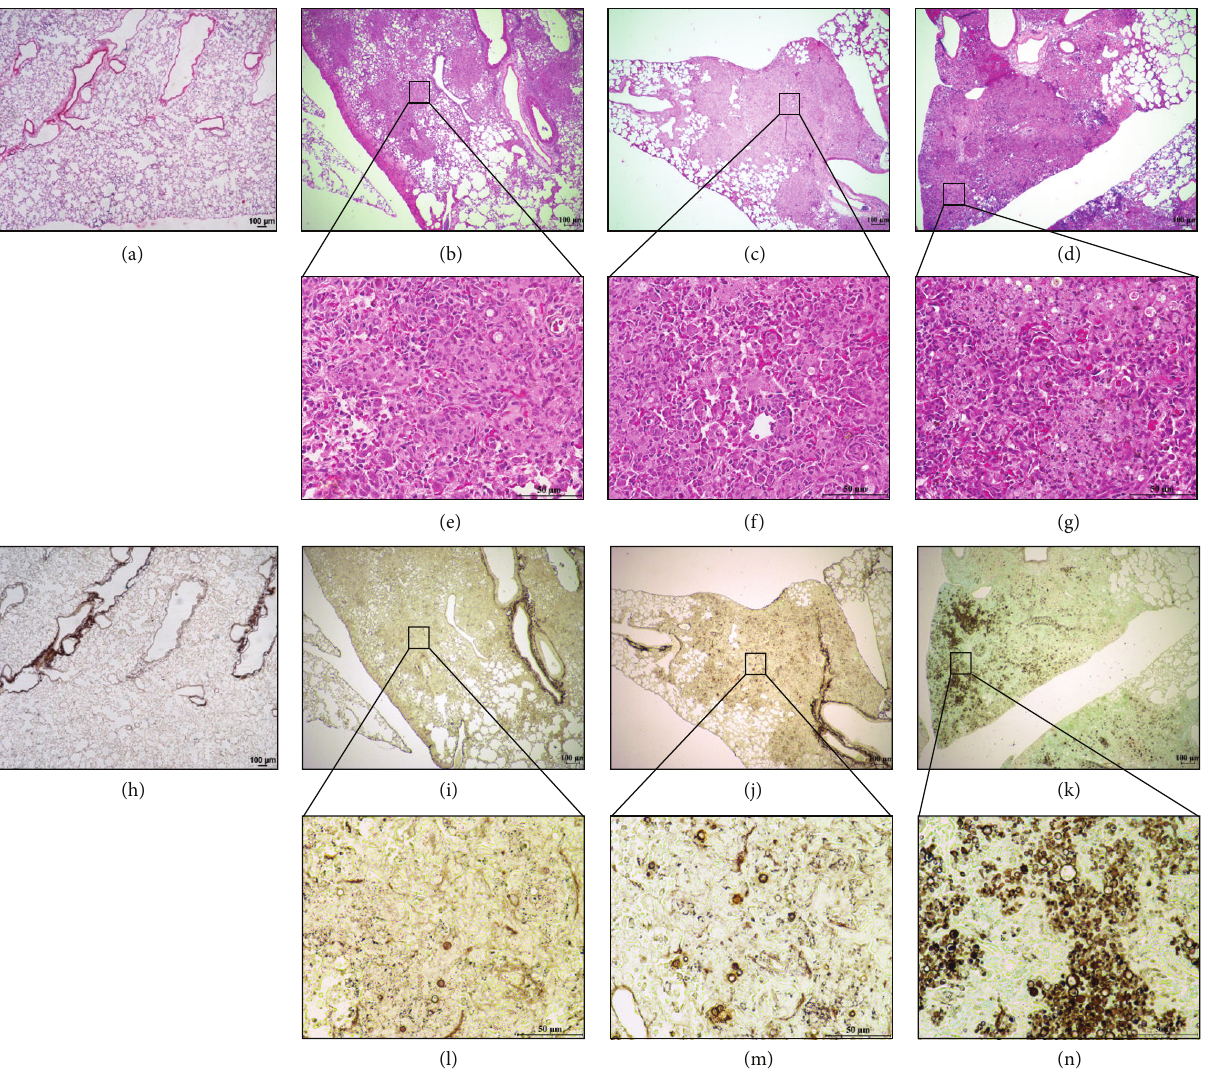
Figure 2: Depletion of neutrophils is associated with an exacerbated inflammatory response in lungs of mice infected with P. brasiliensis during the acute phase. The microphotographs shown are representative of lungs from mice infected or noninfected and treated or not with the anti-Ly6G specific mAb against neutrophils at 96h after challenge and obtained from 4-5 mice/group. Lungs were fixed, embedded in paraffin, cut, and stained using H&E staining (a–g) to determine lung inflammatory response and methenamine silver staining (h–n) to identify P. brasiliensis yeast cells as described in the Materials and Methods section. Arrowheads indicate P. brasiliensis yeast cells (in brown). These results are representative of two independent experiments. (a) and (h) Control mice (inoculated with PBS); (b), (e), (i), and (l) infected, untreated mice; (c), (f), (j), and (m) infected mice treated with isotype control Ab; (d), (g), (k), and (n) infected mice treated with